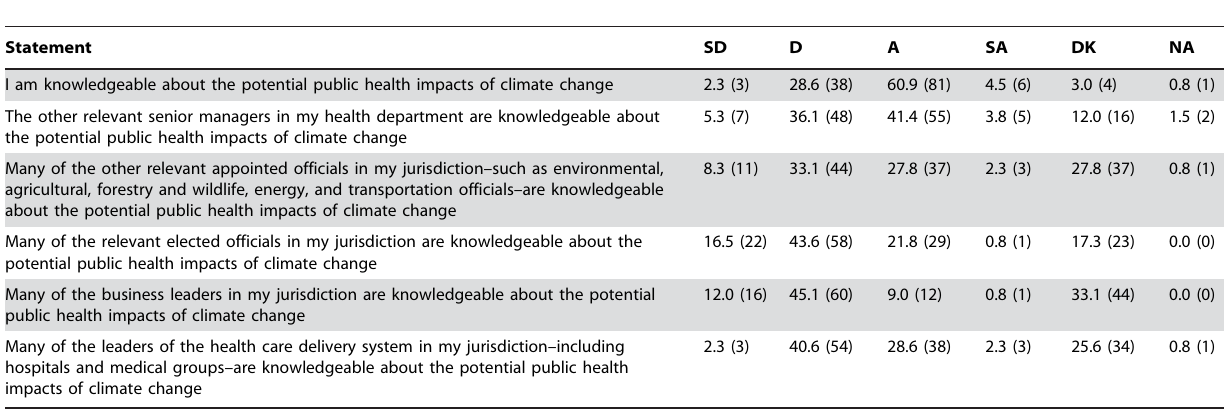
Table 3. Local health department director’s perceptions of climate change knowledge in their health department and among other relevant leaders in the